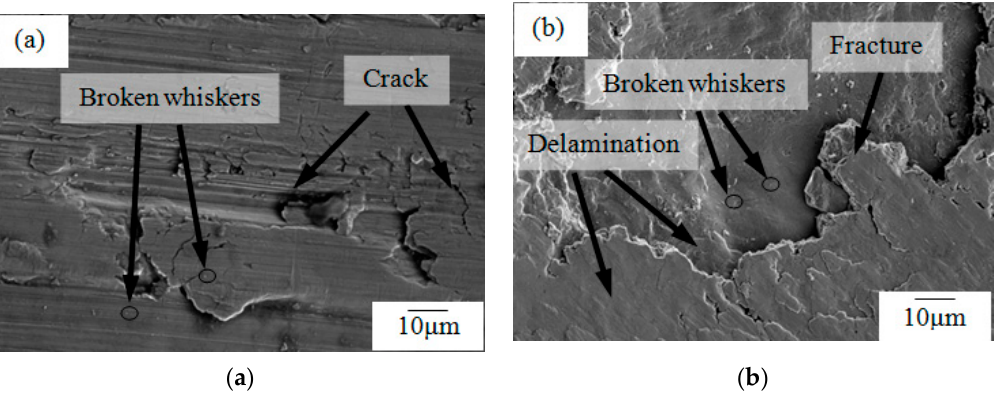
Figure 9. Scanning electron microscopy (SEM) images of surface morphologies of drilled hole walls of the TiBw/TC4 composite. ( a ) The entrance of the hole; ( b ) 0.15mm from the entrance of the hole.